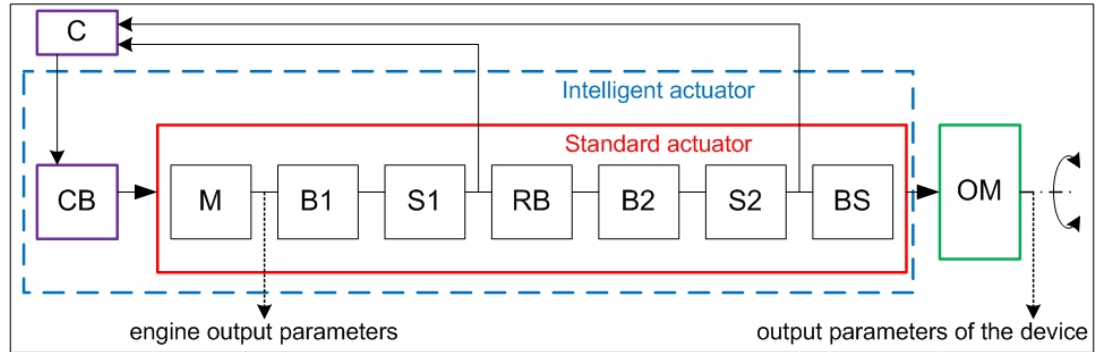
Figure 1. Actuator’s system model.